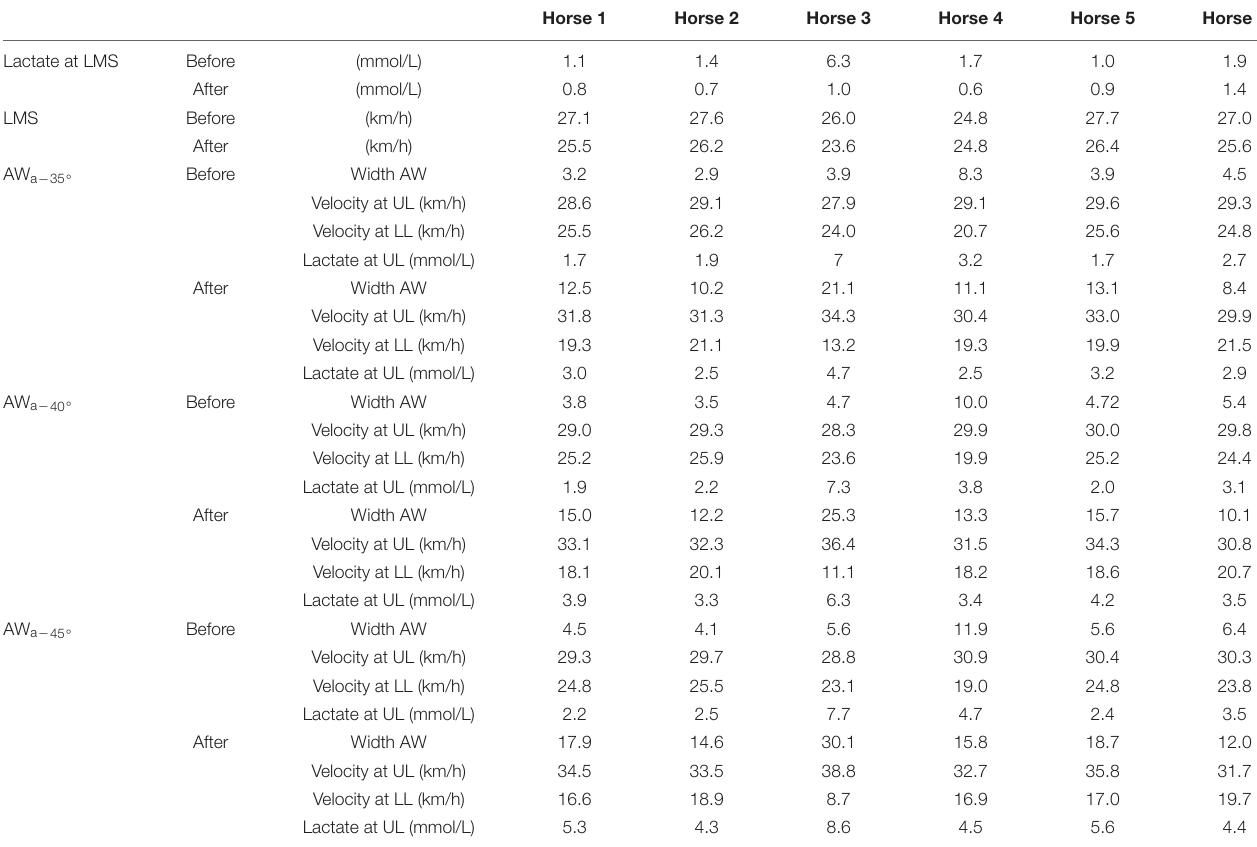
TABLE 2 | Assessment of the width of the aerobic window of each horse (UL minus LL), using the angular approach (AW a ) at tangent angles of respectively 35, 40, and 45 ◦ . Horse 1 Horse 2 Horse 3 Horse 4